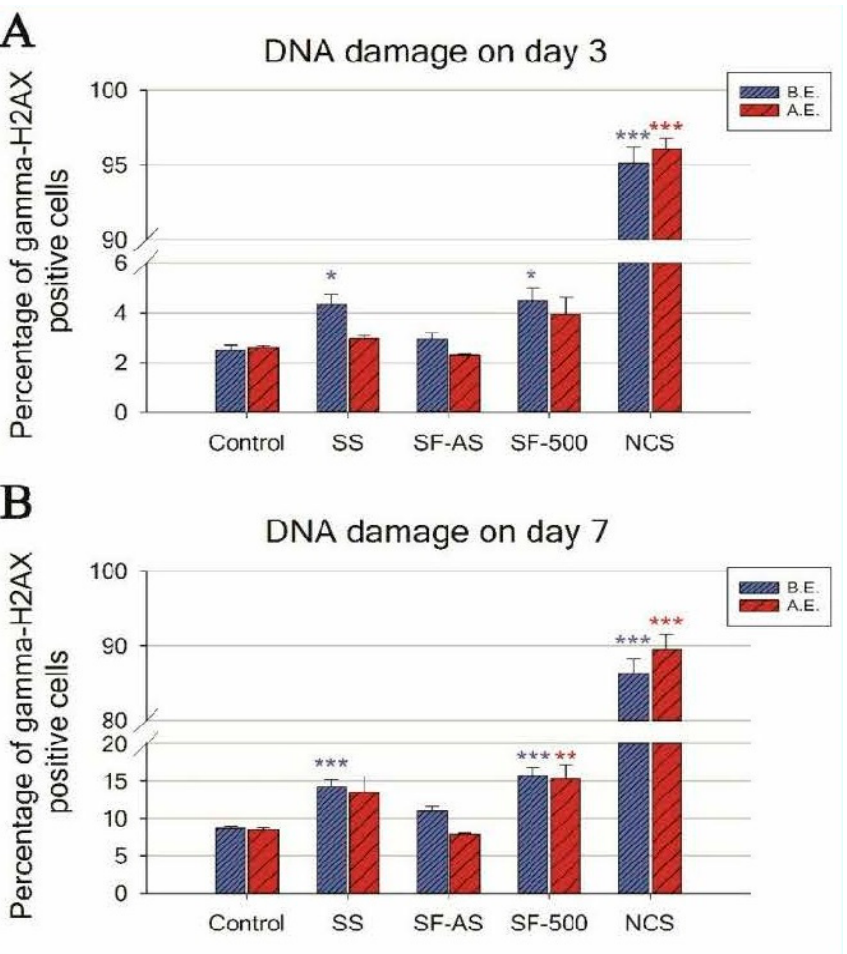
Figure 6. Flow cytometry of the marker of DNA double-strand breaks: gamma-H2AX in human osteoblast-like U-2 OS cells cultured on SF-AS and SF-500 before and after evacuation. The graphs show the percentage of gamma-H2AX positive cells after 3 (A) and 7 (B) days of cultivation. SS—stainless steel; NCS—positive control to phosphorylation of histone H2AX (gamma-H2AX) induced by 1 h incubation of U-2 OS in neocarzinostatin (NCS; 700 ng M). The blue columns illustrate the samples before the evacuation (B.E.), while the red columns depict the samples after the evacuation (A.E.). The asterisk represents a significant difference to control with p ≤ 0.05 (*), p ≤ 0.01 (**), and p ≤ 0.001